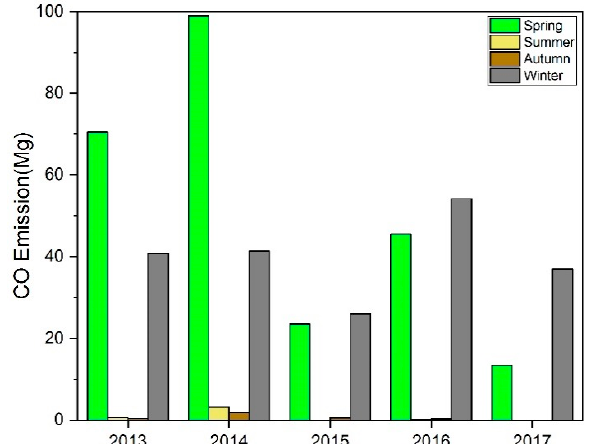
Figure 7. Seasonal distribution of CO emissions from forest fires in southwest China from 2013 to